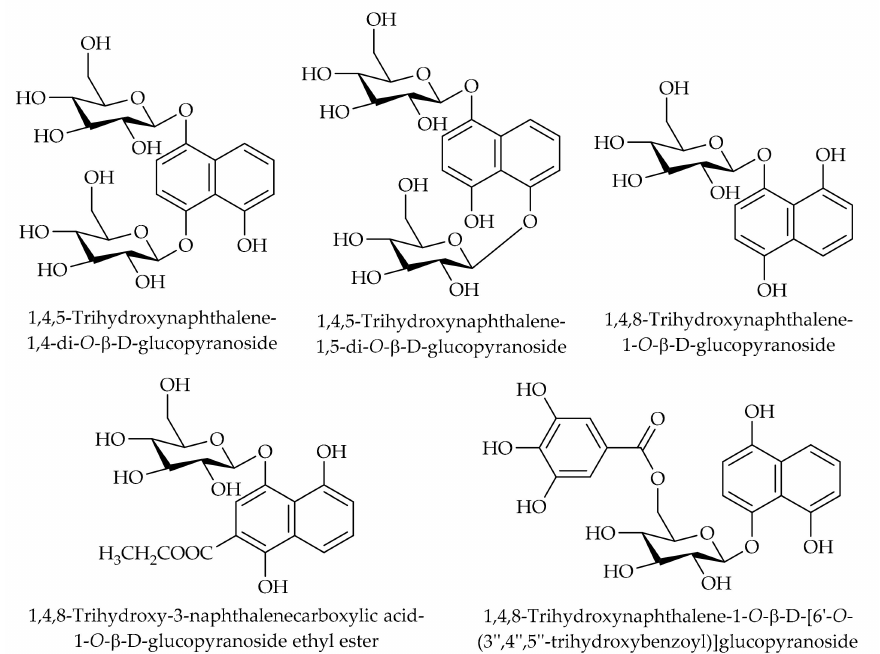
Figure 5. The chemical structures of di ff erent identified, isolated, and quantified naphthoquinone glycosides in the walnut green